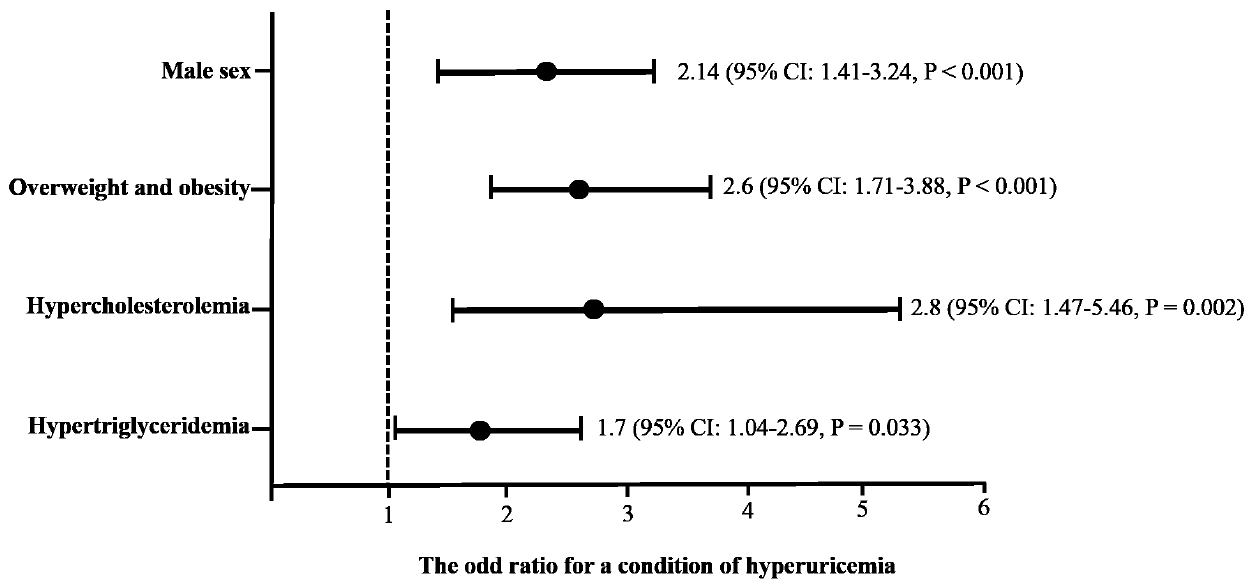
Figure 1. Association of sex, body mass index and dyslipidemias as predictive factors of hiperuricemia using a multivariate logistic regression analysis. The cutoff criteria were based on the World Health Organization and the National Cholesterol Education Program Adult (ATP III). Overweight: body mass index ≥ 25, Obesity: body mass index >30; hypercholesterolemia: fasting serum cholesterol levels > 200 mg/dL; hypertriglyceridemia: fasting serum triglycerides levels > 150